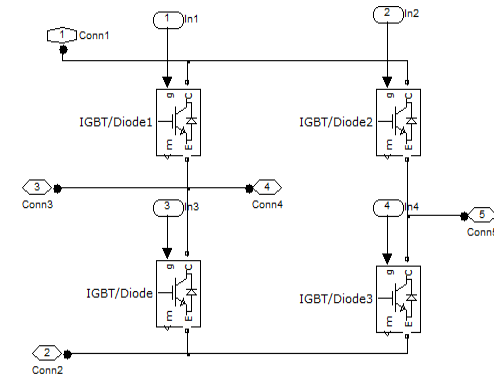
Figure 16 . The Output Voltage waveform of 7-Level